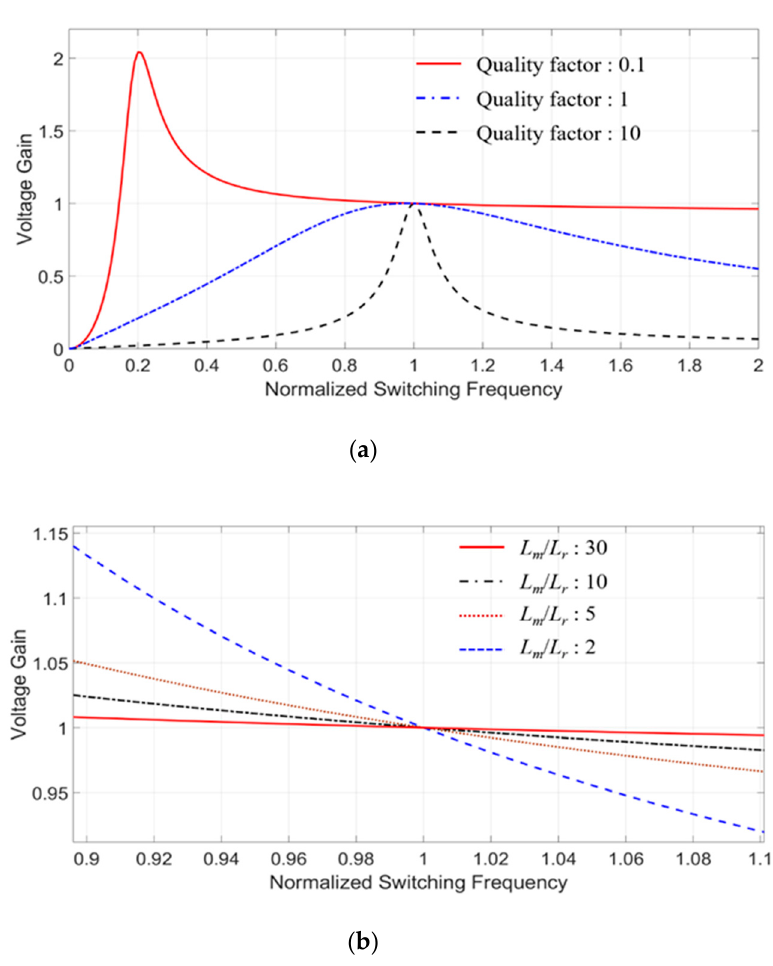
Figure 19. Voltage gain curves shown in [53]: ( a ) according to Q-factor, and ( b ) according to L m / L r .